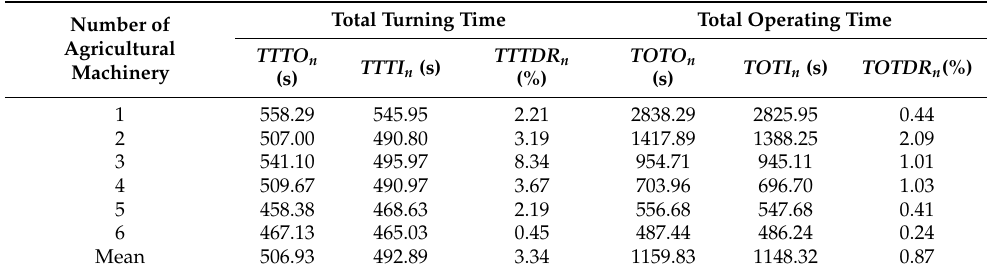
Table 1. Performance comparision of algorithm.